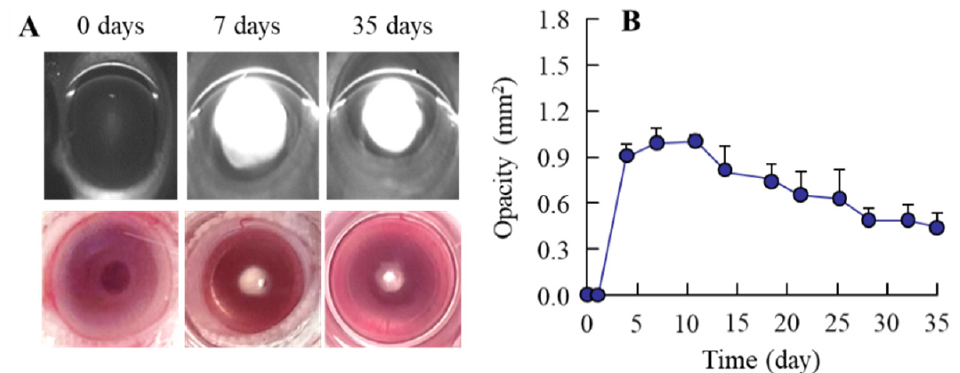
Figure 3. Changes in sodium-selenite-induced opacification in rat lenses. ( A ): digital and Scheimpflug slit images in cataractic rats 0, 7, and 35 days after the injection of sodium selenite. ( B ): changes in opacity levels in the sodium-selenite-induced cataractic rats ( n = 12). The lens opacification was caused by the injection of sodium selenite, and the opacity level was observed at 3 d after the injection.